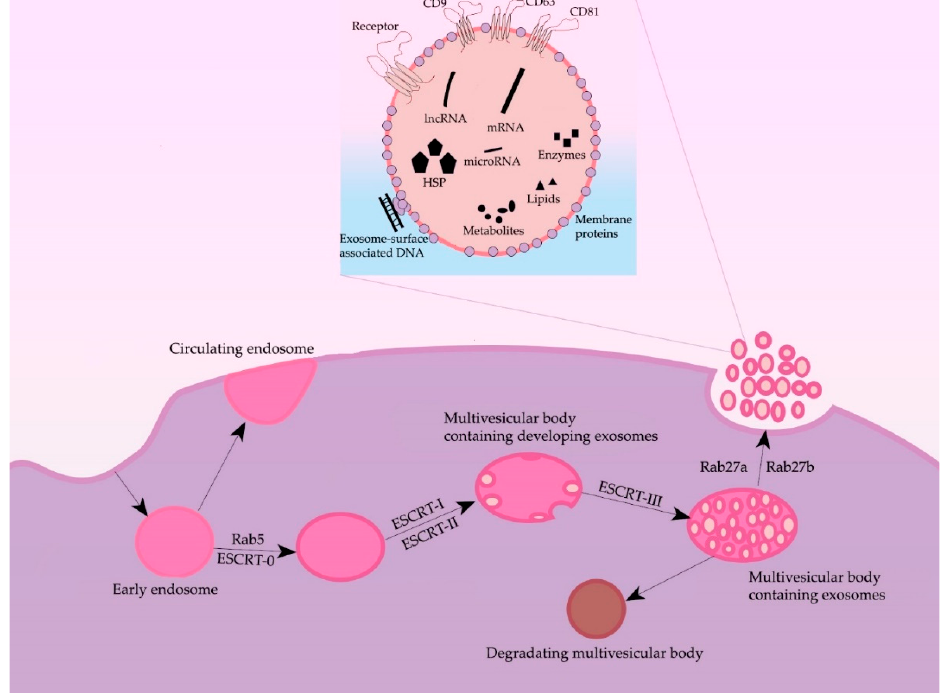
Figure 1. General scheme of processes of formation and secretion of exosomes and their main reg- ulators.